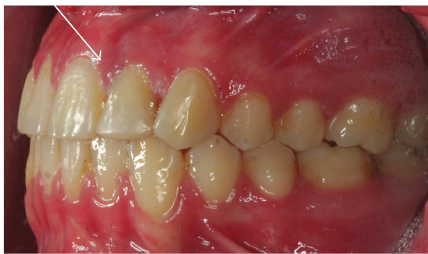
Figure 10: After orthodontic and restorative treatment clinical appearance of fused tooth; intraoral left labial